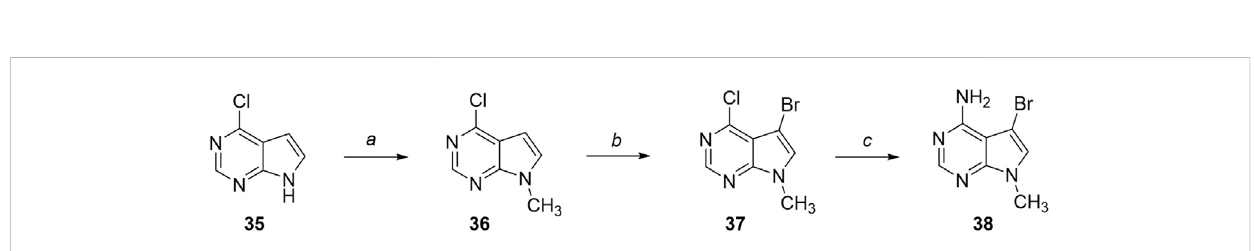
FIGURE 4 Synthesis of the coupling reagent 5-Bromo-7-methyl-7 H -pyrrolo [2,3- d ]pyrimidin-4-amine. Reagents and conditions: (a) 4-chloro-7 H-